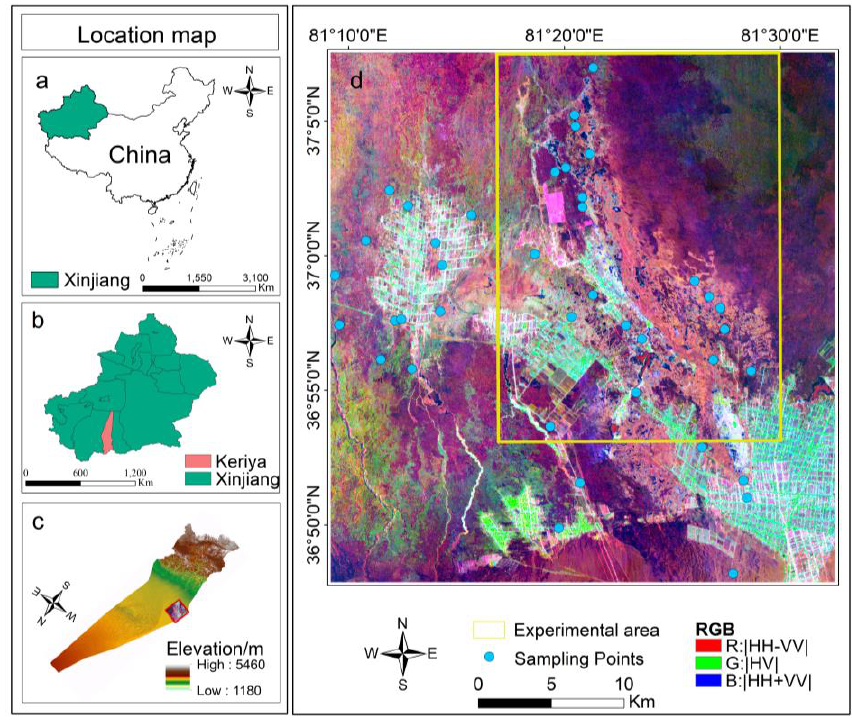
Figure 1. Map of the study area. ( a ) Northwestern China; ( b ) Keriya Oasis in Xinjiang; ( c ) study area in Keriya Oasis; ( d ) PALSAR-2 image of study area.